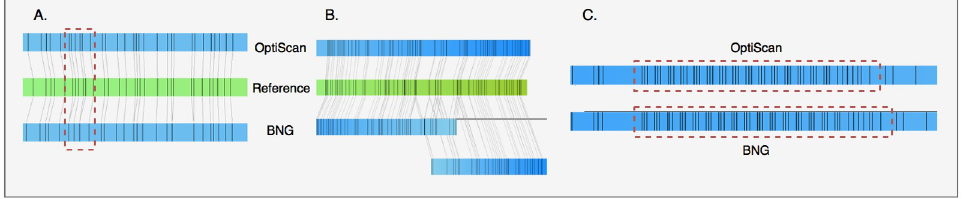
Fig 7. Comparison of 3 different contigs assembled by the BNG assembler using molecules extracted by OptiScan and by BNG software. A. OptiScan molecules can have higher resolution, which often more accurately matches the reference genome (i.e. the in silico generated optical map). B. In some cases, OptiScan-based assembly results in better contiguity. C. A long repeat on chromosome 12, not present in the reference genome, was assembled differently based on the two molecule sets.